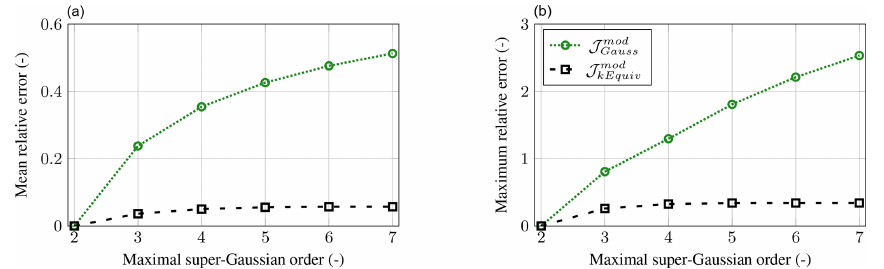
Figure 1. Mean (a) and maximal (b) relative error of the analytical integrals compared with the numerical evaluation of J as a function of the maximal considered super-Gaussian